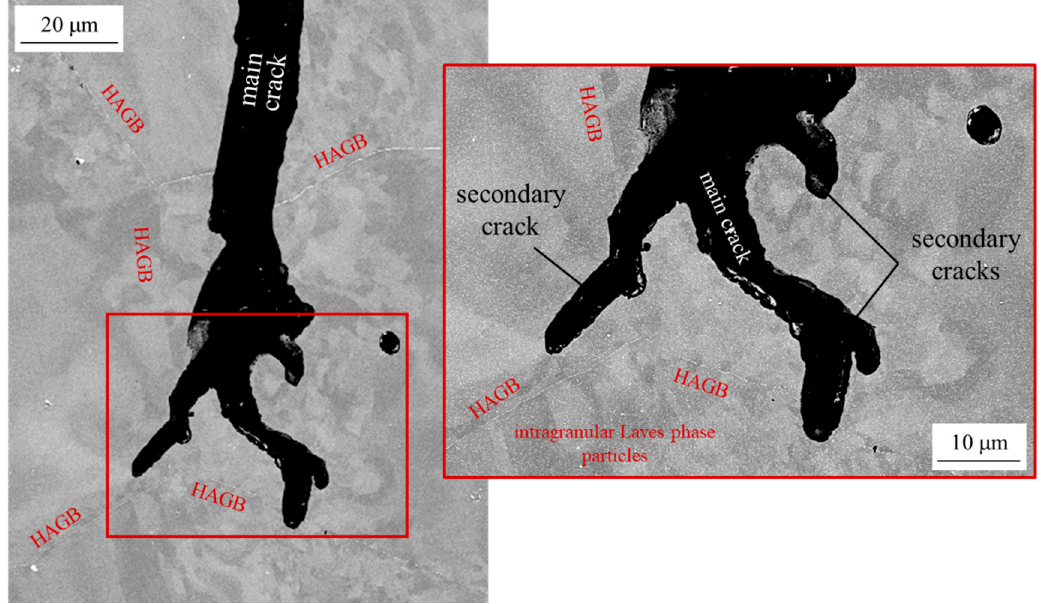
Figure 10. Crack branching at deformation induced sub-grain boundaries in Crofer ® 22 H after TMF failure (SEM micrograph).